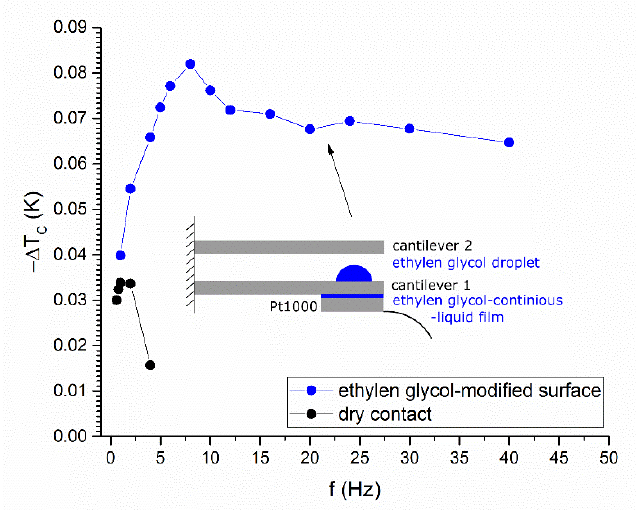
Figure 8. Improving the thermal contacts as a proof-of-concept experiment. The surface of cantilever 1 was modified using ethylene glycol. The blue curve shows the frequency dependence of the temperature drop on the thermistor (heat source) when ethylene glycol is used (the case for cantilever 1 active). It is evident that the ethylene glycol droplets improved the contact and increased the temperature drop compared to the dry contacting (black).